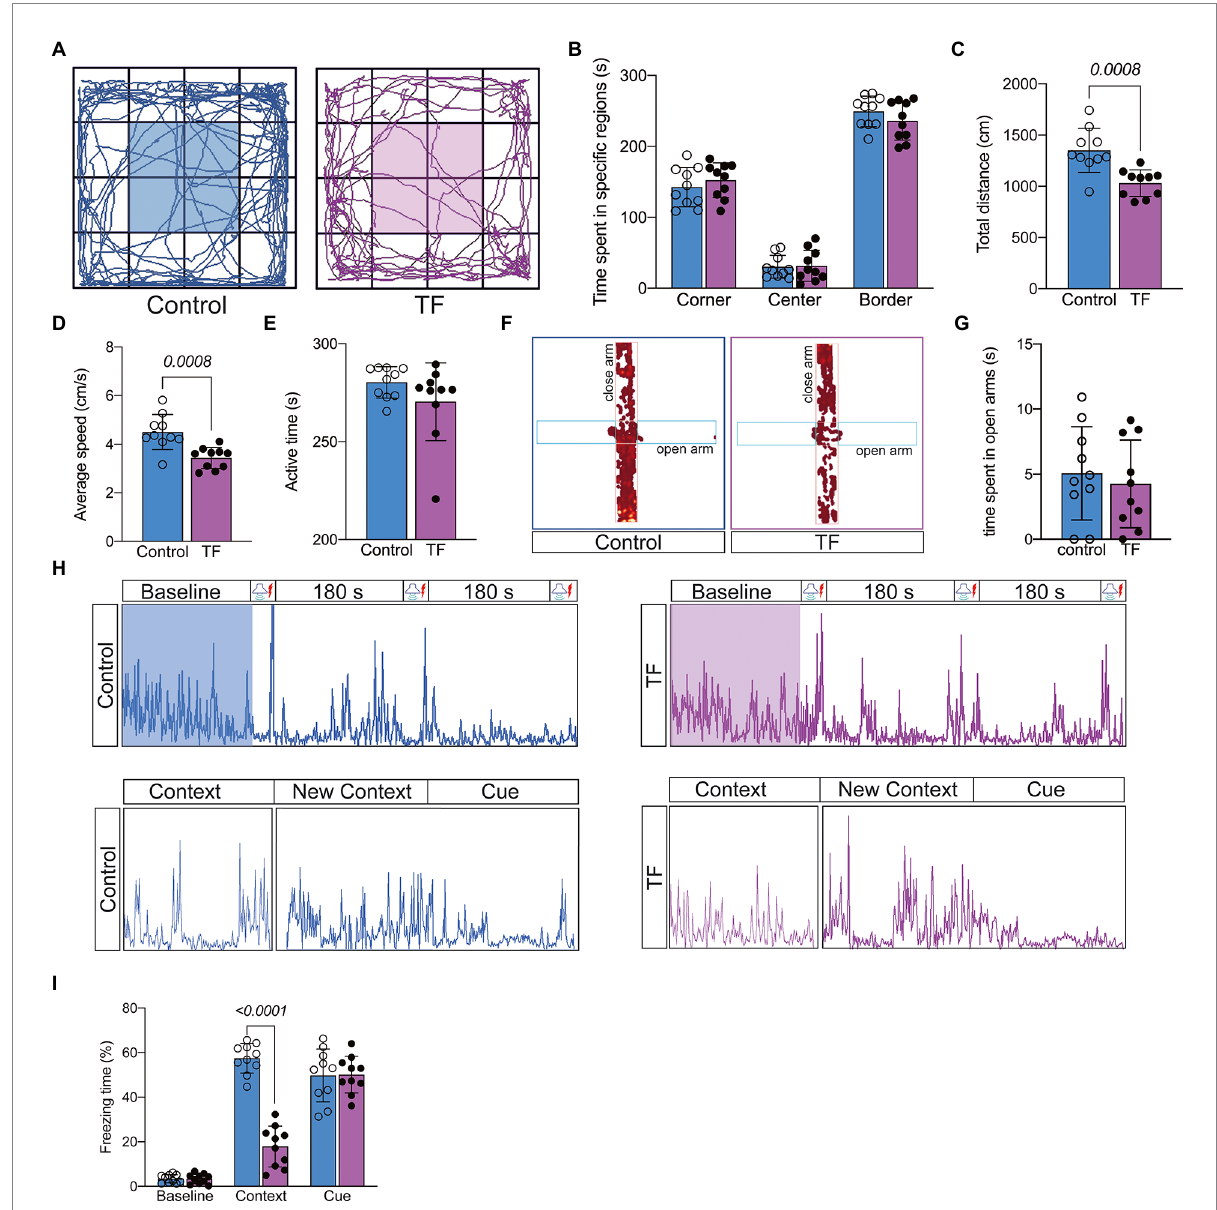
FIGURE 2 Behavioral testing of aged mice after tibial fracture surgery. (A) Mobility of aged mice was measured by the open-field test on the 7th day after fracture surgery. (B–E) Comparison of the results of the open-field test between the two groups of mice. (F,G) Anxiety in aged mice was measured using the elevated plus maze on day 7 after fracture surgery. (H) The image above shows the activity of mice trained in 3 cycles of Context (180 s)- Cue (30 s)-Shock (2 s) pairing on day 8 after fracture surgery. The image below shows the activity of the mice during the test phase on day 9 after fracture surgery: Context (180 s), Novel Context (180 s)-Cue (180 s). (I) Comparison of the percentage of freezing time in each phase for both groups of mice. Data were expressed as mean ± SD and analyzed using two-tailed unpaired t -test. The p -values are shown in the